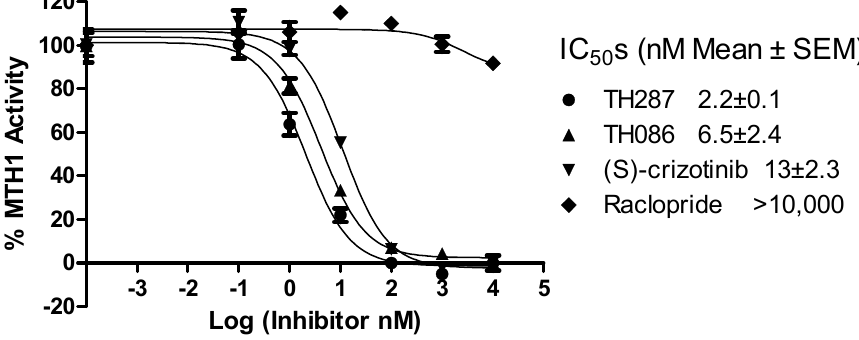
Figure 5. MTH1 inhibition assay shows that TH287, TH086, and (S)-crizotinib have high inhibition potency, with IC 50 s 2.2, 6.5, and 13 nM respectively. While a non-active compound Raclopride was used as a control compound; n = 2, samples in triplicate; substrate dGTP concentration: 100 uM, and recombinant MTH1 protein: 0.5 nM.